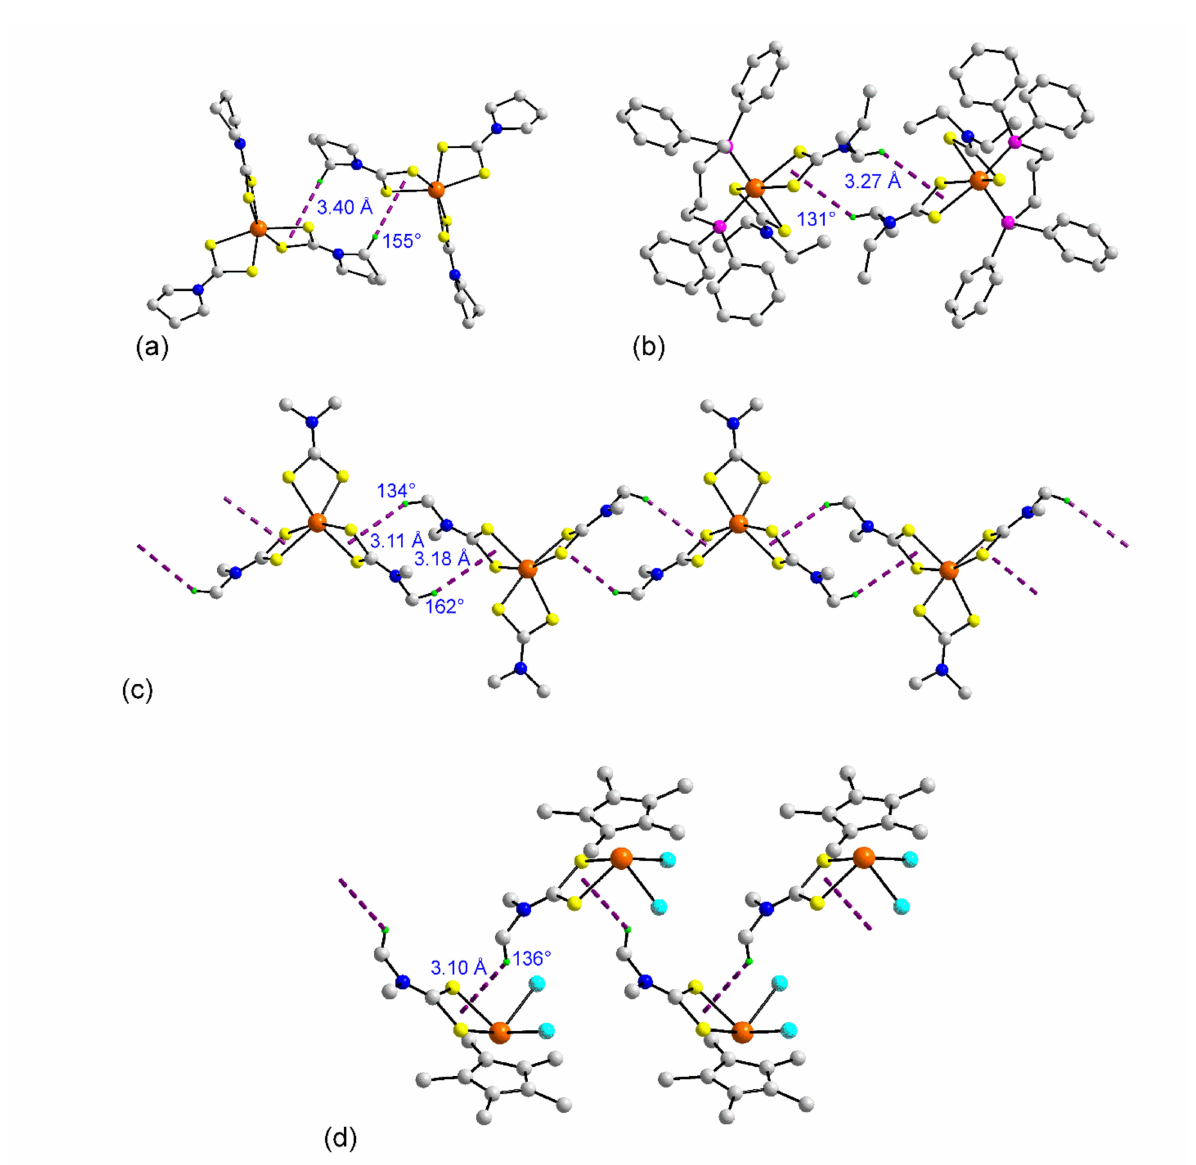
Figure 6. Supramolecular aggregation between molecules in the crystals of ( a ) 3 , ( b ) 8 , ( c ) 1 , and ( d ) 58 . The C–H · · · π (RuS 2 C) interactions are represented by dashed purple lines, and the distances and angles associated with the C–H · · · π (RuS 2 C) interactions are given on each image.